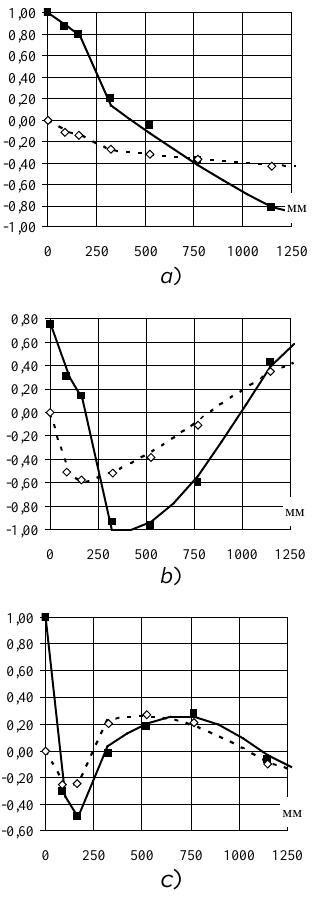
Fig. 5. Waveforms of torsional vibrations at natural frequencies: a) – 593, b) – 1262 and c) – 1885 Hz. Lines are the simulation results obtained in ANSYS (solid line: the original model, natural frequencies without brackets; dotted line: model with a fixed motor rotor, natural frequencies in brackets). Markers are chain models.